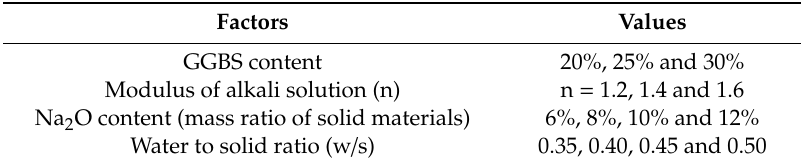
Table 2. Parameters which influence the properties of alkali-activated LFA-GGBS hybrid